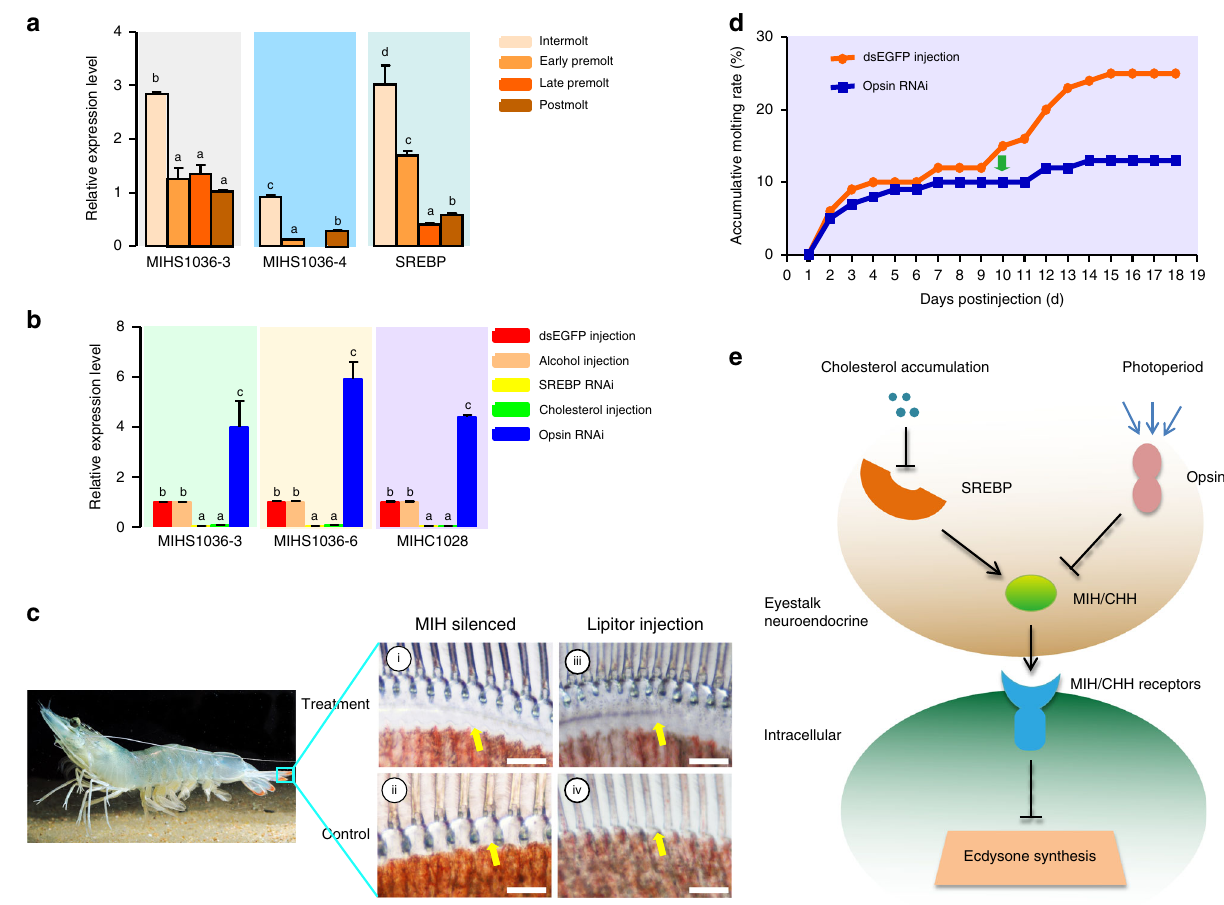
Fig. 5 Regulation of MIH-mediated ecdysone synthesis in shrimp. a The expression patterns of SREBP and MIH s in shrimp eyestalks at different molting stages. b The expression pro fi les of MIH s in the eyestalk with different treatments. Injections of dsEGFP and PBS serve as controls. c Phenotype changes of the shrimp uropods cuticle after treatments. Shrimps at the intermolt stage were treated by RNAi: (i) 2 days after injection of dsMIH; (ii) 2 days after injection of dsEGFP. Shrimps at the early premolt stage were used for Lipitor treatment: (iii) 2 days after injection of Lipitor; (iv) 2 days after injection of PBS. Yellow arrows indicate the space between old and new cuticles at different molting stages. Bar = 50 μ m. d Effect of opsin silencing on accumulative molting rates, with the injection of dsEGFP serving as a control. The green arrow shows the time when the treatment led to a signi fi cantly lower accumulated ecdysis rate compared to the control group. e The schematic diagram of the regulation of SREBP and opsin on the MIH-mediated ecdysone synthesis. SREBP SRE-binding